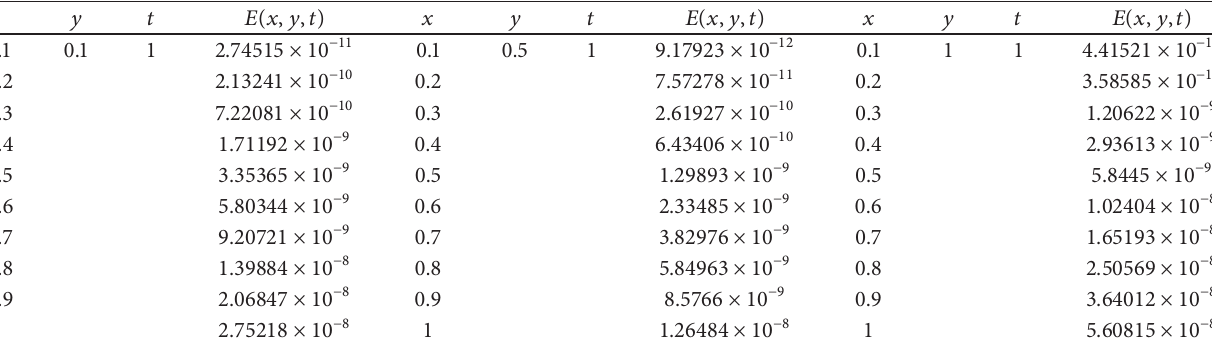
Table 2: Maximum absolute errors for problem (40) for 𝑇 = 1 and 𝑁 = 𝑀 = 12 .